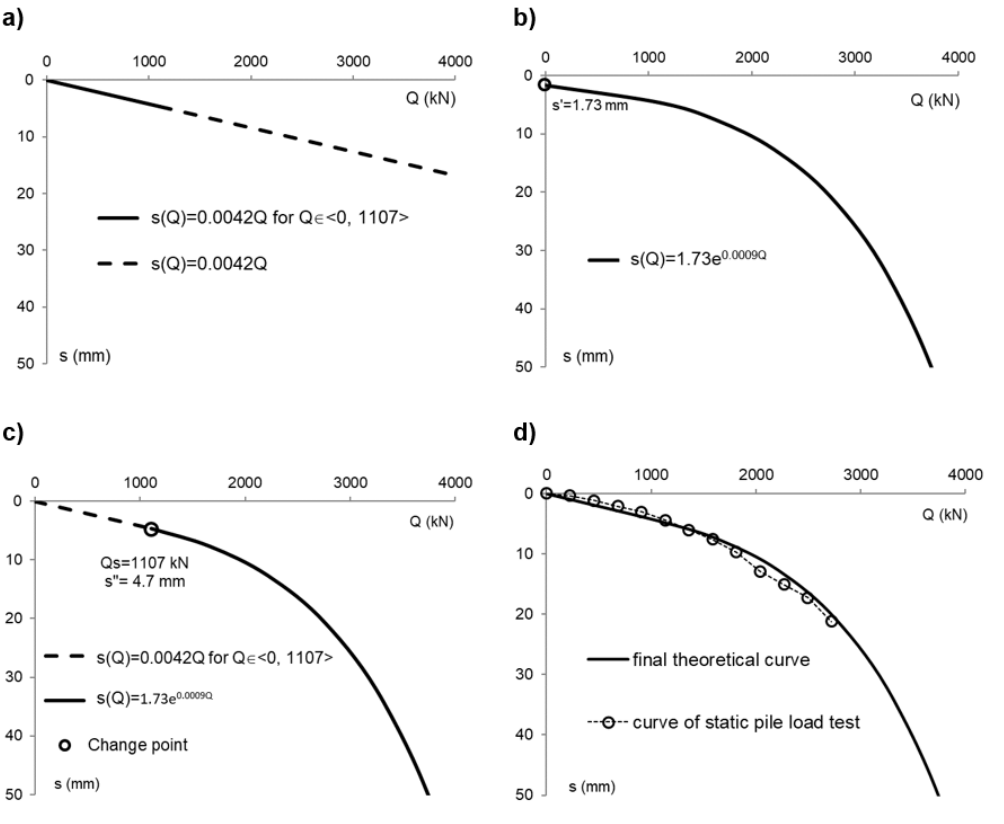
Figure 8: Stages of Q–s characteristics prediction based on the proposed procedure: (a) linear elastic stage; (b) non-linear elastic stage; (c) combination of the linear elastic stage for Q Î <0, Q > and non-linear elastic stage; (d) comparison of the theoretical curve with the measured s curve from static load